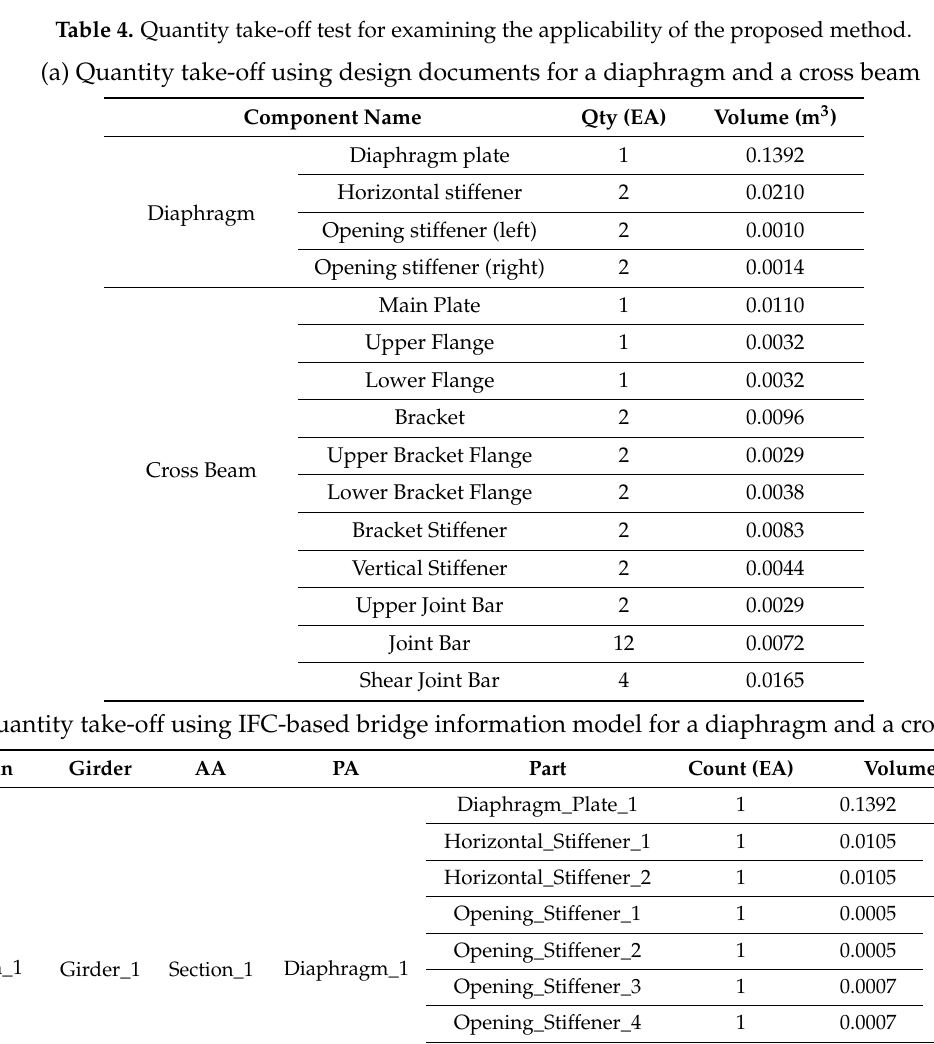
Table 4. Quantity take-off test for examining the applicability of the proposed